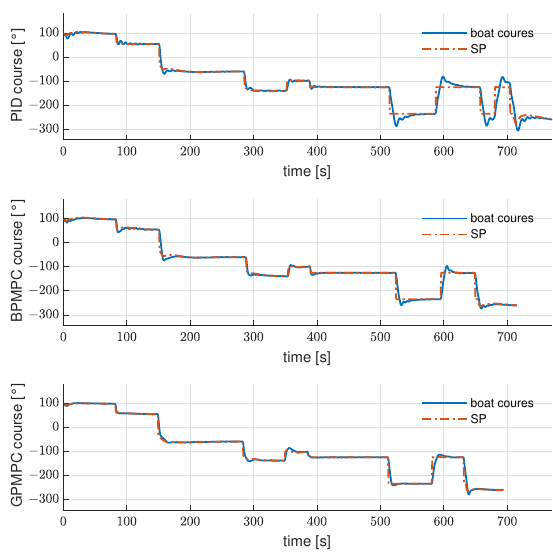
Figure 24. The response curve of heading change with and without course compensation for LOS with current disturbance. The top graph shows the PID control case, the middle graph shows the BPMPC control case, and the bottom graph shows the GPMPC control case. The solid blue line is the actual heading and the dashed orange line is the target